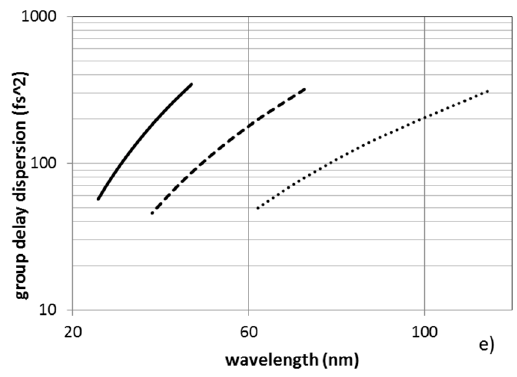
Figure 4. Performance of a high-resolution TDC monochromator for HHs. ( a ) Slit width to have the GD equal to the Fourier limit in the output bandwidth; ( b ) Output bandwidth corresponding to the slit width at the different wavelengths; ( c ) Pulse-front tilt at the intermediate slit, 4-mrad XUV divergence; ( d ) GD and Fourier limit calculated for the bandwidth shown in ( b ); ( e ) GDD. Monochromator parameters: q = 800 mm, p = 150 mm.